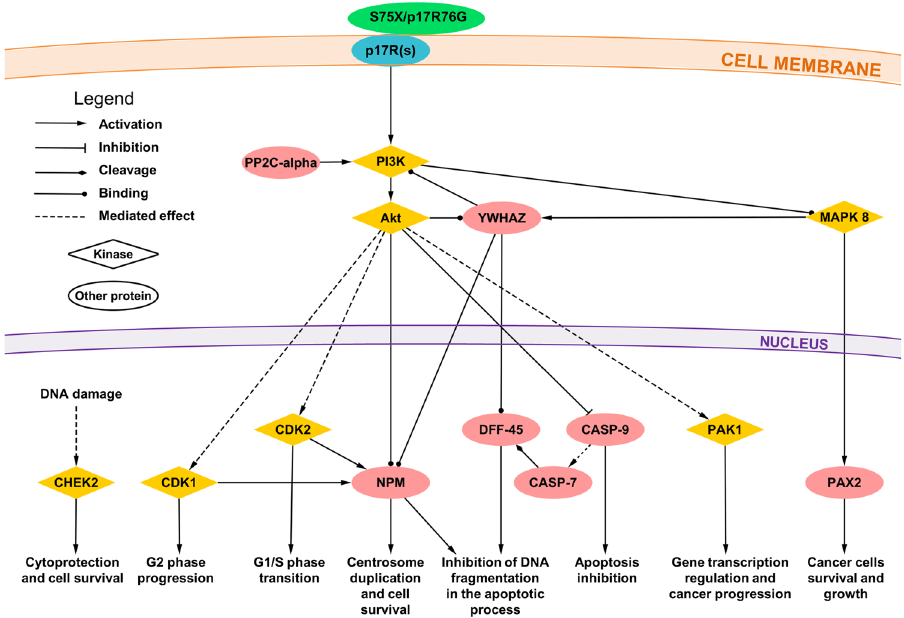
Figure 5. Representation of the putative signaling pathways involved in B-cell clonogenicity induced by interaction of S75X/p17R76G with p17R(s). Stimulation of B cells with the clonogenic p17 proteins, S75X and p17R76G, induces the activation of several molecules involved in promoting cell survival, cell cycle progression and in inhibiting apoptosis, and STRING database and literature data mining were used to identify known and experimentally verified interactions. The several kinases involved in the pathway are indicated by orange diamonds, the other proteins are represented by light red ellipses. PI3K: phosphatidylinositol-3-kinase; Akt: Protein kinase B;PP2C-alpha: Protein phosphatase 1A; MAPK8: Mitogen-activated protein kinase 8; YWHAZ: 14-3-3 protein zeta/delta; CHEK2: Checkpoint kinase 2; CDK1: Cyclin-dependent kinase 1; CDK2: Cyclin- dependent kinase 2; NPM: Nucleophosmin; DFF-45: DNA fragmentation factor subunit alpha; CASP-9: caspase-9; CASP-7: caspase-7; PAK1: Serine/threonine-protein kinase PAK 1; PAX2: Paired box protein